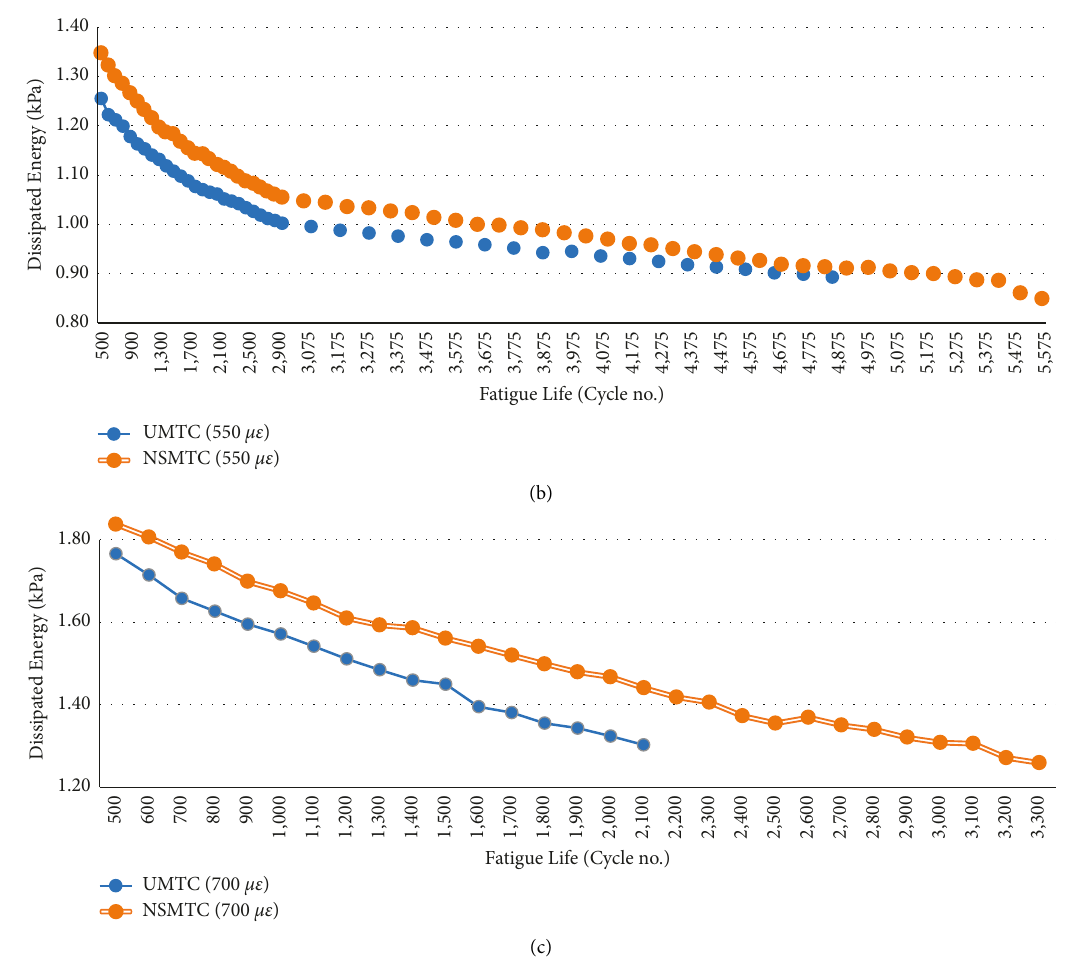
Figure 3: Changes in dissipated energy against fatigue life of UMTC and NSMTC specimens at the strain levels of (a) 400, (b) 550, and (c) 700 με